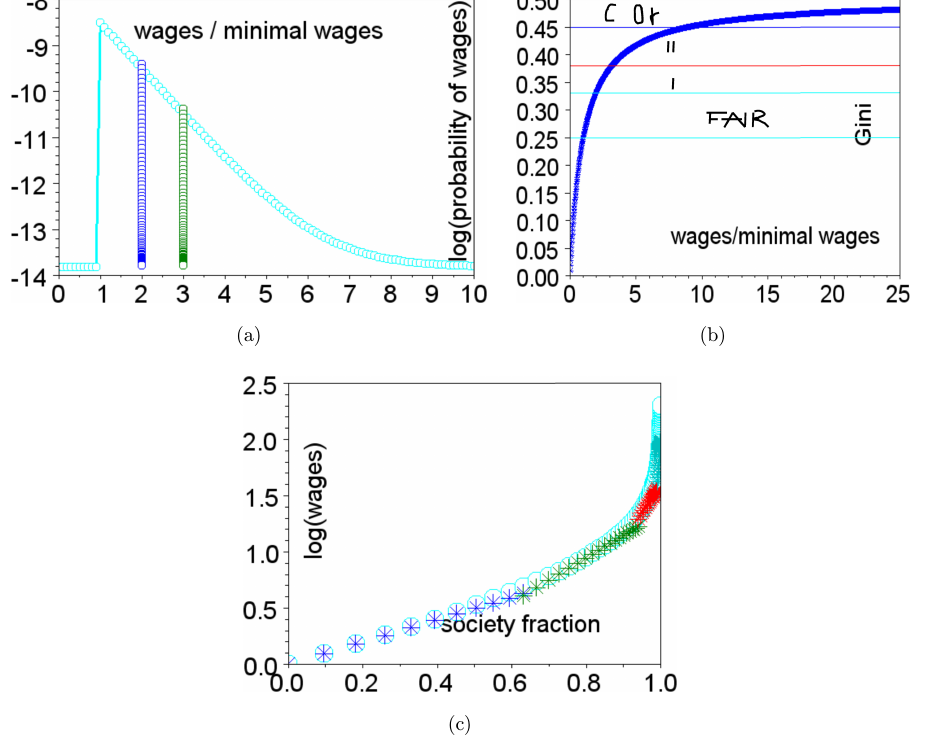
Fig. 1. (a) A log linear plot of the exponential income density function. The ¯rst vertical curve is (cid:1) , the second is (cid:2) þ (cid:1) (with cumulative probability 63%), the third is 3 (cid:1) (the °uctuations (cid:3) from the average) (with cumulative probability 86%). (b) The Gini for the exponential income density function as a function of (cid:2) , wages, in terms of (cid:1) , therefore with normalization wages/minimal wages ( x -axis). The fair Gini is within the light blue horizontal lines. The three other regimes are highlighted, I (departure from fairness), II (corruption built nation), Cor (corrupt). (c) The society income curve on a log linear scale, with the normalization, wages/minimal wages ( y -axis). This function is the income of every fraction in the society. The form is a multi exponential with a slope one and two for the whole group of 95% of the society (blue and green curves), and then a slope 5 to the deciders top 4% before the top 1% (red curve), and a slope 50 to the top 1% (light green). The function is continuous at the top, where those from the top 0.1% earn just ¯ve times the